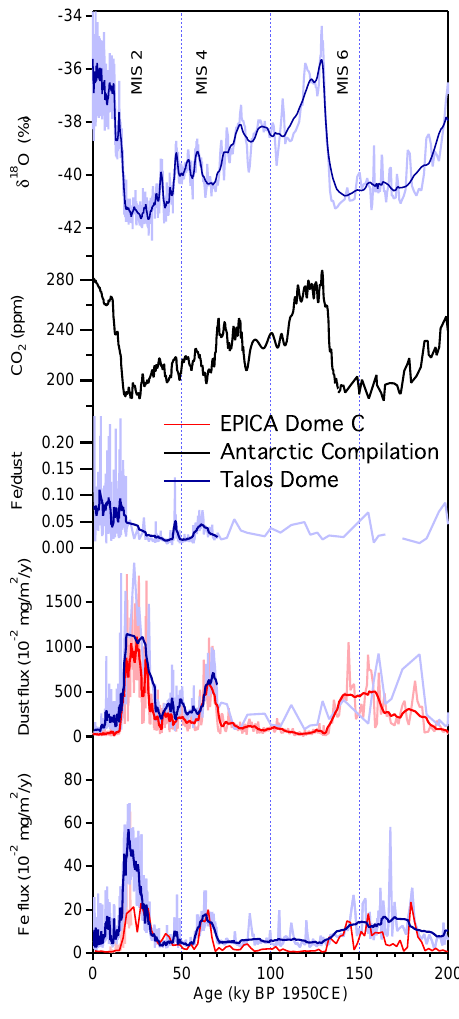
Fig. 2. Deglacial changes in Fe, nssCa 2 + and dust at Dome C and Talos Dome. TALDICE δ 18 O values are from (Stenni et al., 2011). Fine (1–5µm)/coarse (5–10µm) dust particle ratios are from Al- bani et al. (2012) and dust fluxes are from Delmonte et al. (2010). All dust concentrations were determined by coulter counter. EPICA Dome C dust fluxes are from Lambert et al. (2008). nssCa 2 + data are shown for TD (this study) and EDC (R¨othlisberger et al., 2002) ice cores. Deglacial EDC Fe fluxes are from Gaspari et al. (2006). The vertical dashed lines, located at 11.9 and 12.9kyrBP, highlight enhanced Fe fluxes which occur independently of dust fluxes at Ta- los Dome and Dome C, respectively.